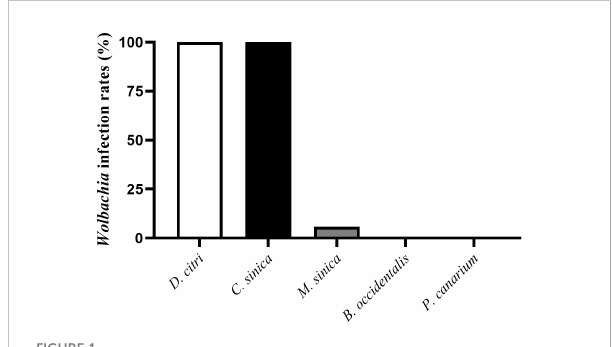
FIGURE 1 Wolbachia infection rates in different species of